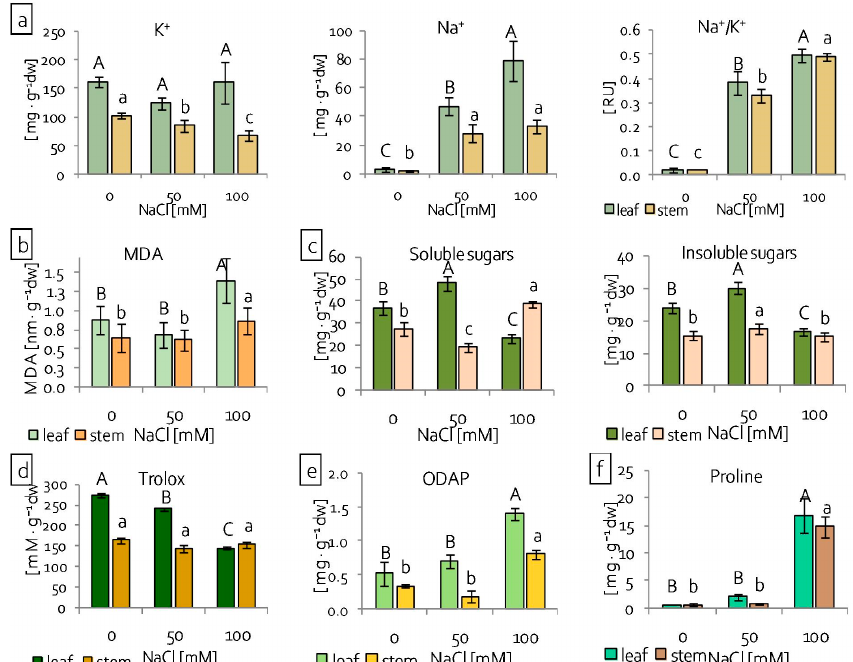
Figure 2. Reaction of grass pea leaves and stems to salinity stress: ( a ) distribution of K + and Na + ions; ( b ) malondialdehyde (MDA) content; ( c ) content of soluble and insoluble sugars; ( d ) total antioxidant capacity (as Trolox equivalents); ( e ) content of β -N-oxalyl-L- α , β -diamino propionic acid (ODAP); and, ( f ) content of proline; different letters—statistically significant differences within each organ (leaf-uppercase, stem-lowercase) at p ≤ 0.05; ( n = 5). Int. J. Mol. Sci. 2021 , 22 , x FOR PEER REVIEW